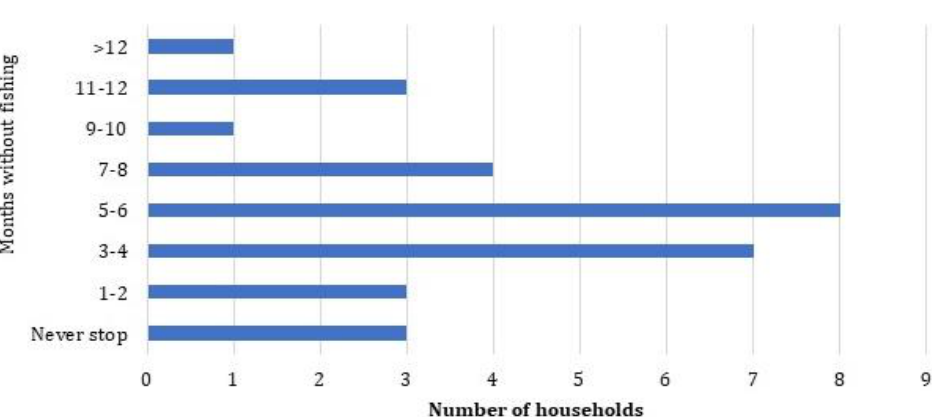
Fig. 3. Amount of time households did not catch fish following the FHS incident (own